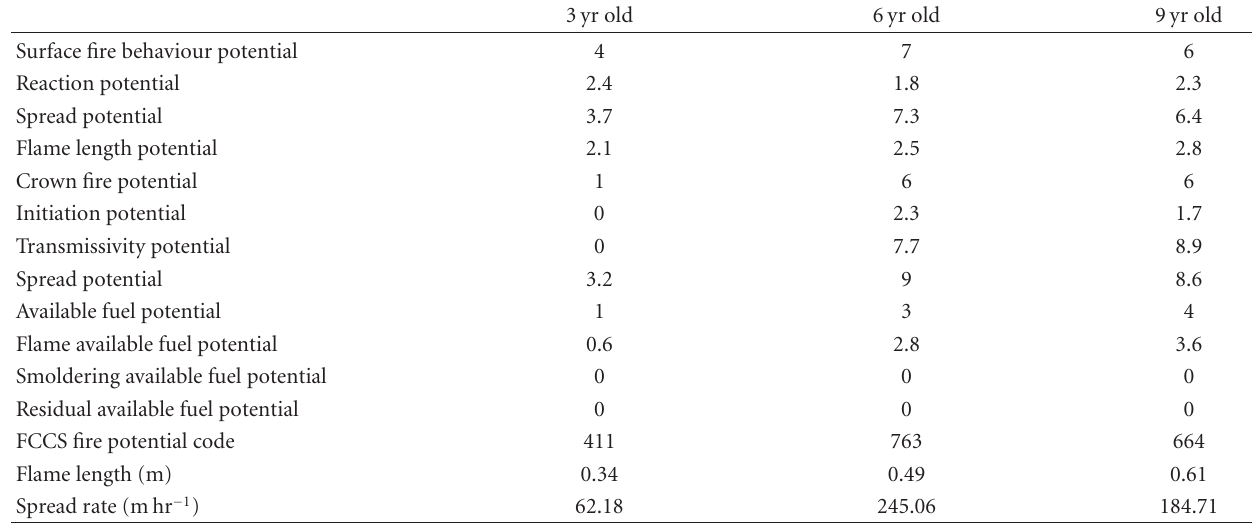
Table 4: FCCS fire behavior potentials for eucalyptus plantations at 3, 6, and 9 years after planting. FCCS potentials are index values.